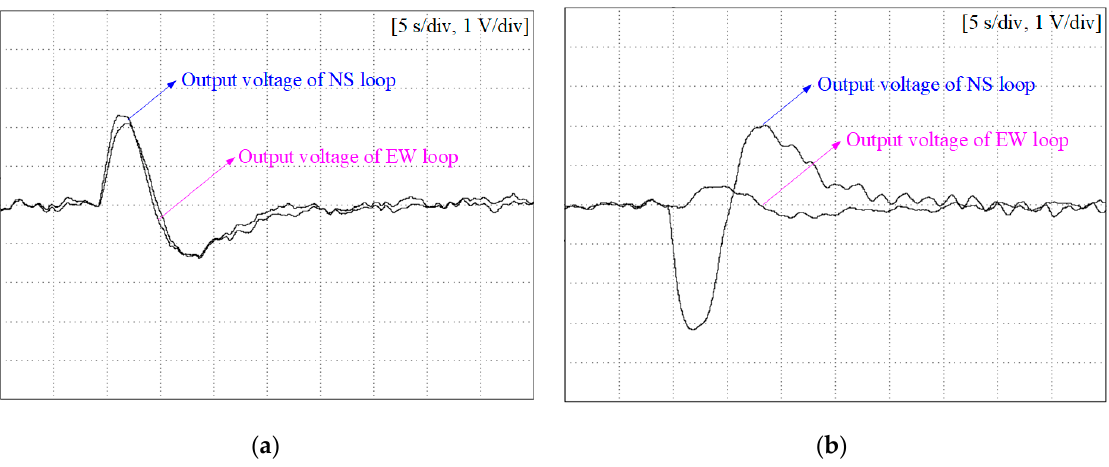
Figure 6. Examples of output voltages of loop antennas. ( a ) Response of antennas placed in north–east direction to positive lightning; ( b ) response of antennas placed in north–south direction to negative lightning.